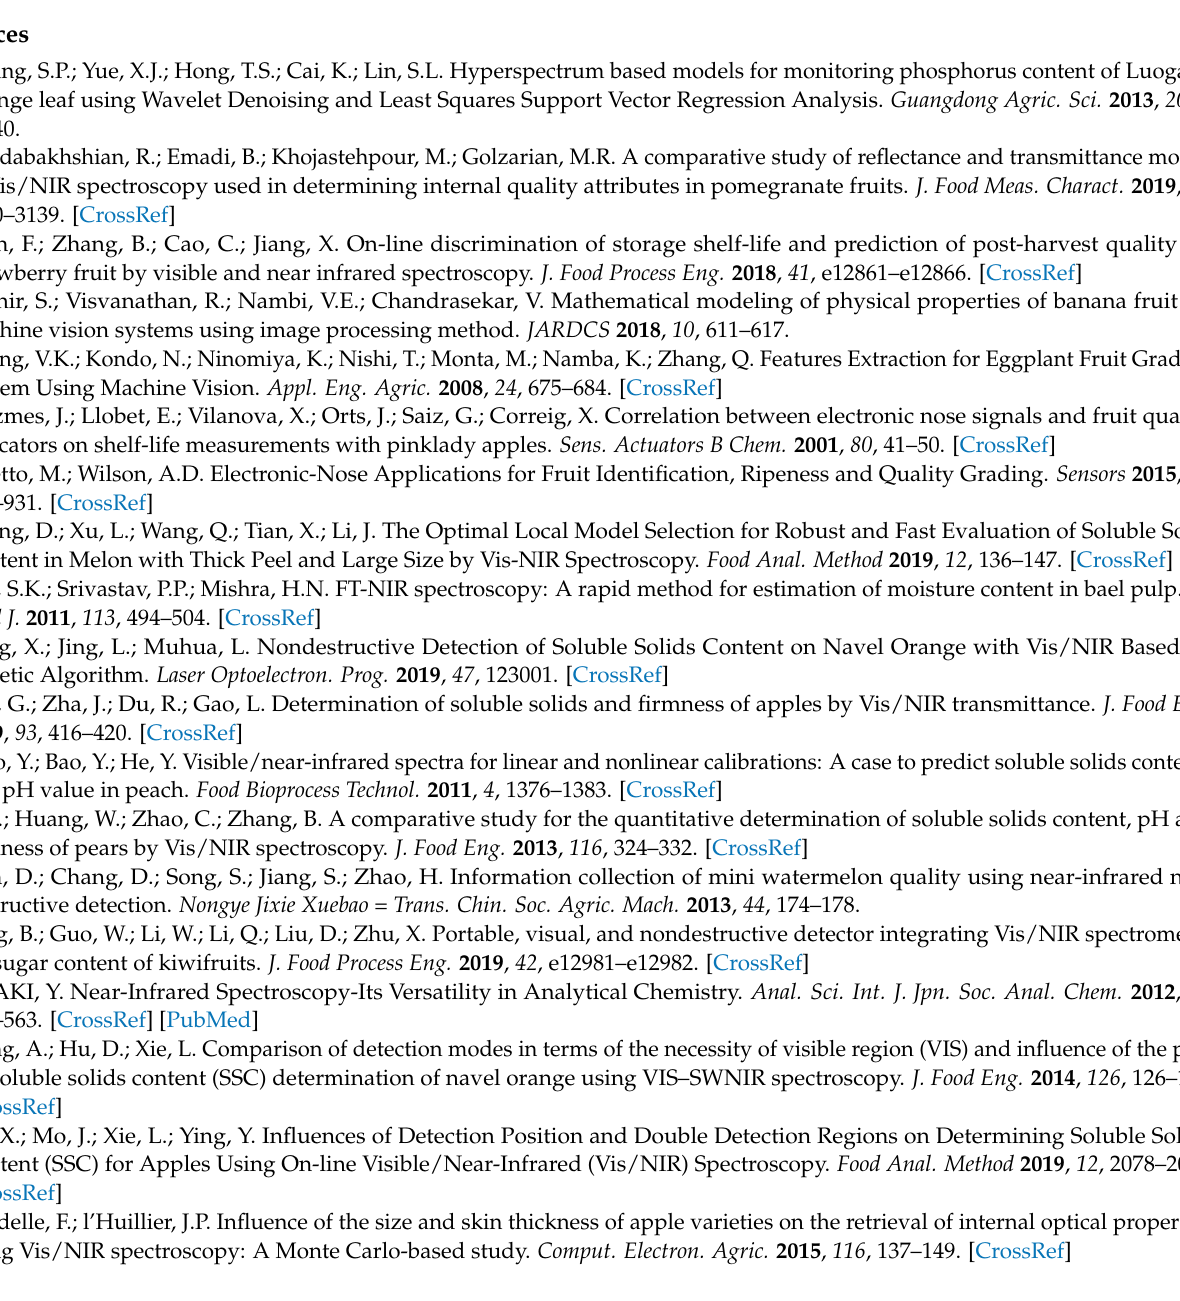
Figure A2. The architecture of convolutional neural network (CNN).